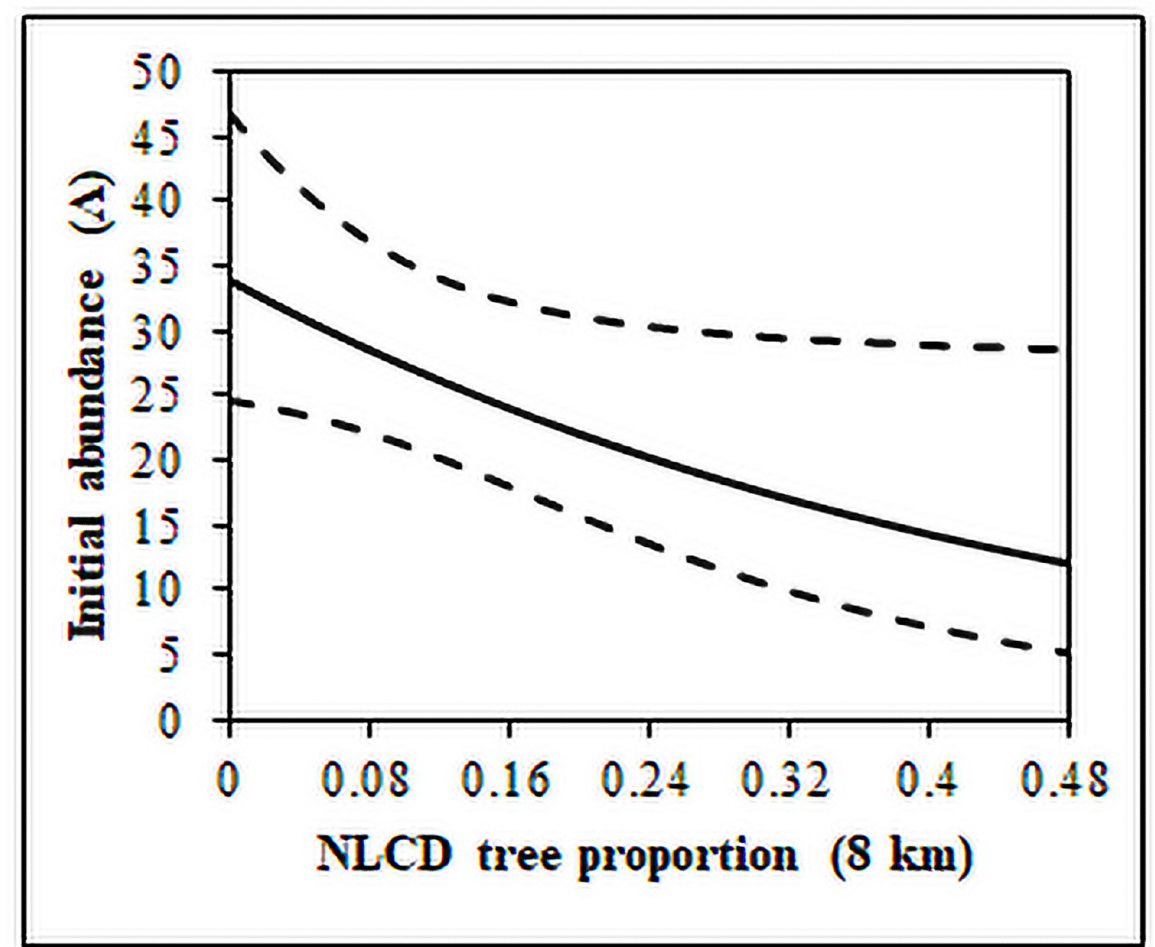
Fig 3. Predicted effect of tree proportion (NLCD) within 8 km of a sage-grouse lek on initial abundance ( Λ ) within the Upland regulation history. Prediction was from top Δ AIC open population N-mixture model for the Upland regulation history with Λ lek specific and related to